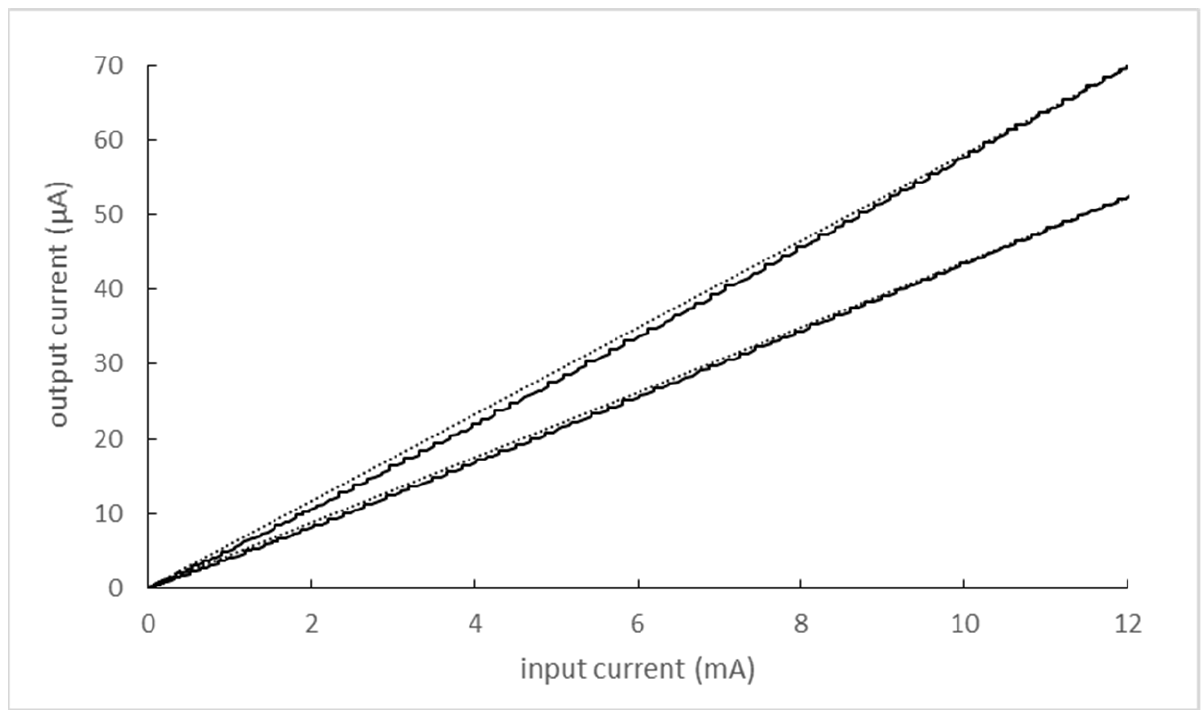
Figure 14. The transfer characteristics of the input and output currents of two optocouplers HCPL- 4562 (black lines—characteristics of both optocouplers; dotted lines—linear dependencies of input and output quantities given by corresponding end points of optocoupler characteristics).